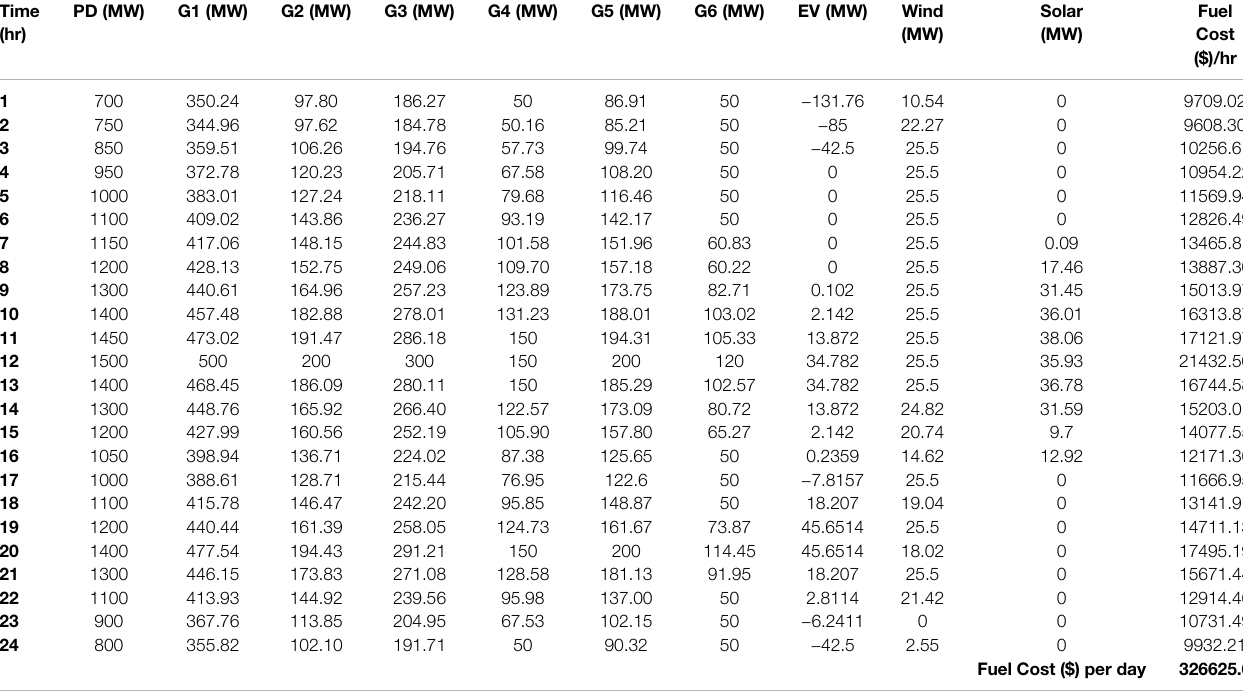
TABLE 3 | 6-unit generator Dynamic Load Dispatch with EVs and RES (without valve point loading effect without losses) using Chimp optimizer algorithm. Time